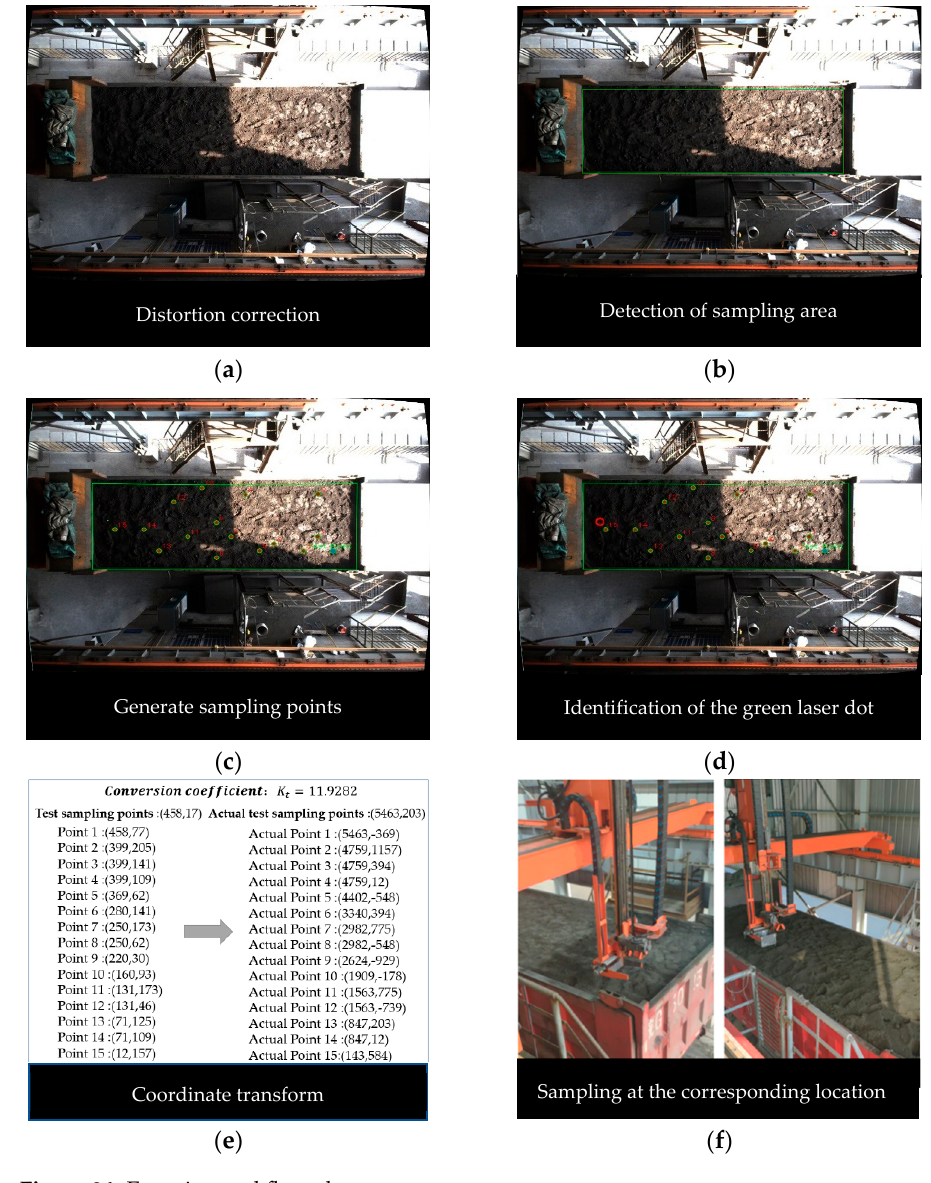
Figure 24. Experimental flow chart.